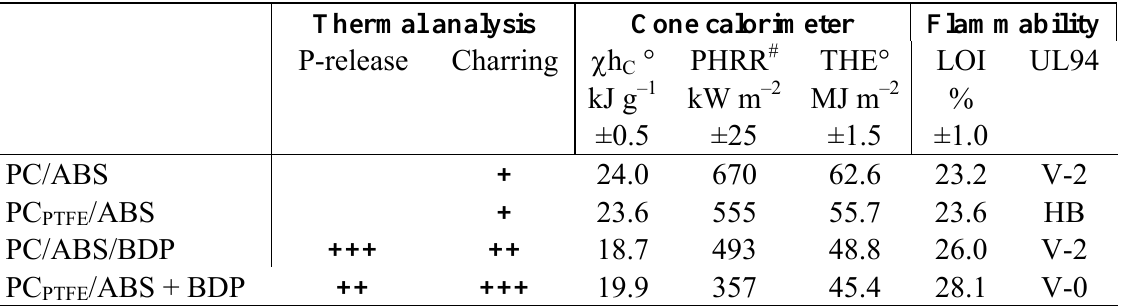
), PHRR and THE determined C /ABS, PC/ABS + PTFE